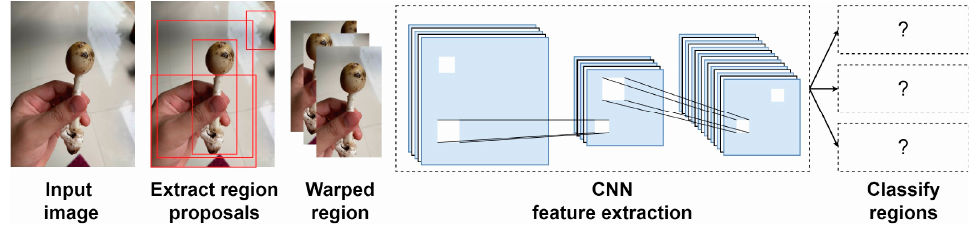
Figure 4. Region convolutional neural network architecture.